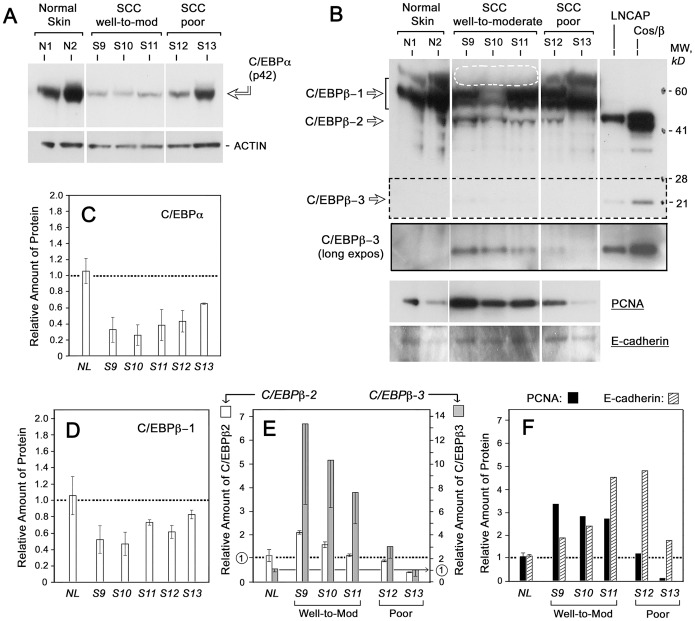
C/EBPα and C/EBPβ expression in human skin SCC.Total protein lysates from normal skin samples (N1, N2), three moderately- or well-differentiated squamous carcinomas (S9, S10 and S11), and two poorly-differentiated squamous cell carcinomas (S12 and S13) were analyzed on western blots. Blots for tubulin and actin were done as loading controls for all samples; only actin is shown. (A) Western analyses for C/EBPα. (B) Western analyses for C/EBPβ. The last two lanes are positive controls, consisting of lysates from a prostate cancer cell line (LNCAP) and from cos-7 cells transfected with a native full-length sequence of human C/EBPβ (cos/β). Solid box, longer exposure of region within dotted lines. At bottom, western blots for PCNA and E-cadherin. (C) Densitometric quantification of C/EBPα. Duplicate gels were scanned, and the range shown by the error bars. (D) Densitometric quantification of C/EBPβ−1 isoform. (E) Densitometric quantification of C/EBPβ−2 and C/EBPβ−3 isoforms. Note that for C/EBPβ-3, the y-axis scale is on the right. (F) Densitometric quantitation of markers for proliferation (PCNA) and differentiation (E-cadherin). All band intensities were normalized to the average of actin and tubulin (not shown). Error bars, range of duplicate measurements.